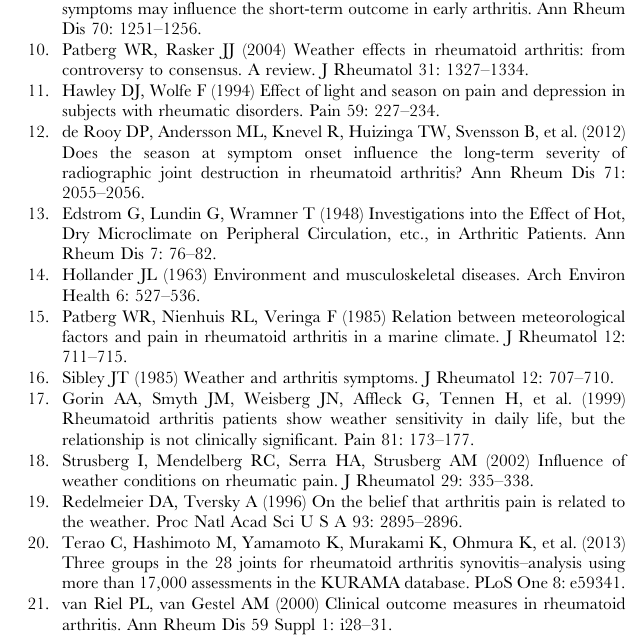
Figure S1 Fluctuations of air pressure and joint syno- vitis in the 326 patients. Fluctuations of each item are illustrated between 2005 and 2012. The three figures of SJC, TJC and combination of SJC and TJC are composed of 326 lines presenting fluctuations in the 326 patients. Table S1 Correlation coefficients of RA joint synovitis in association with air pressure across different evalu- ations. Table S2 Detailed information of the 326 RA